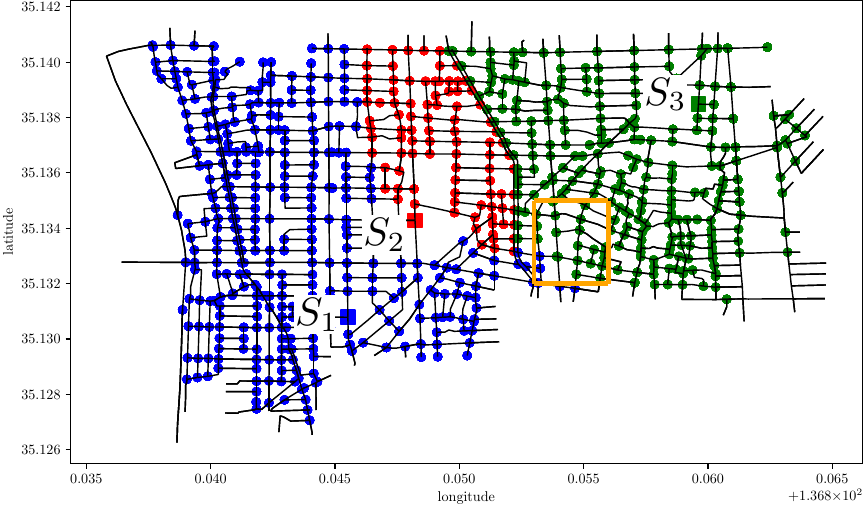
Figure 5. Refuge assignment of distance-based scheme ( β = 0.7).